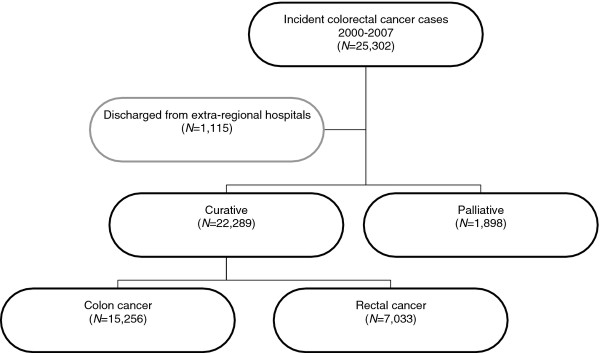
Flow chart of inclusion of colorectal cancer patients into the cohort.